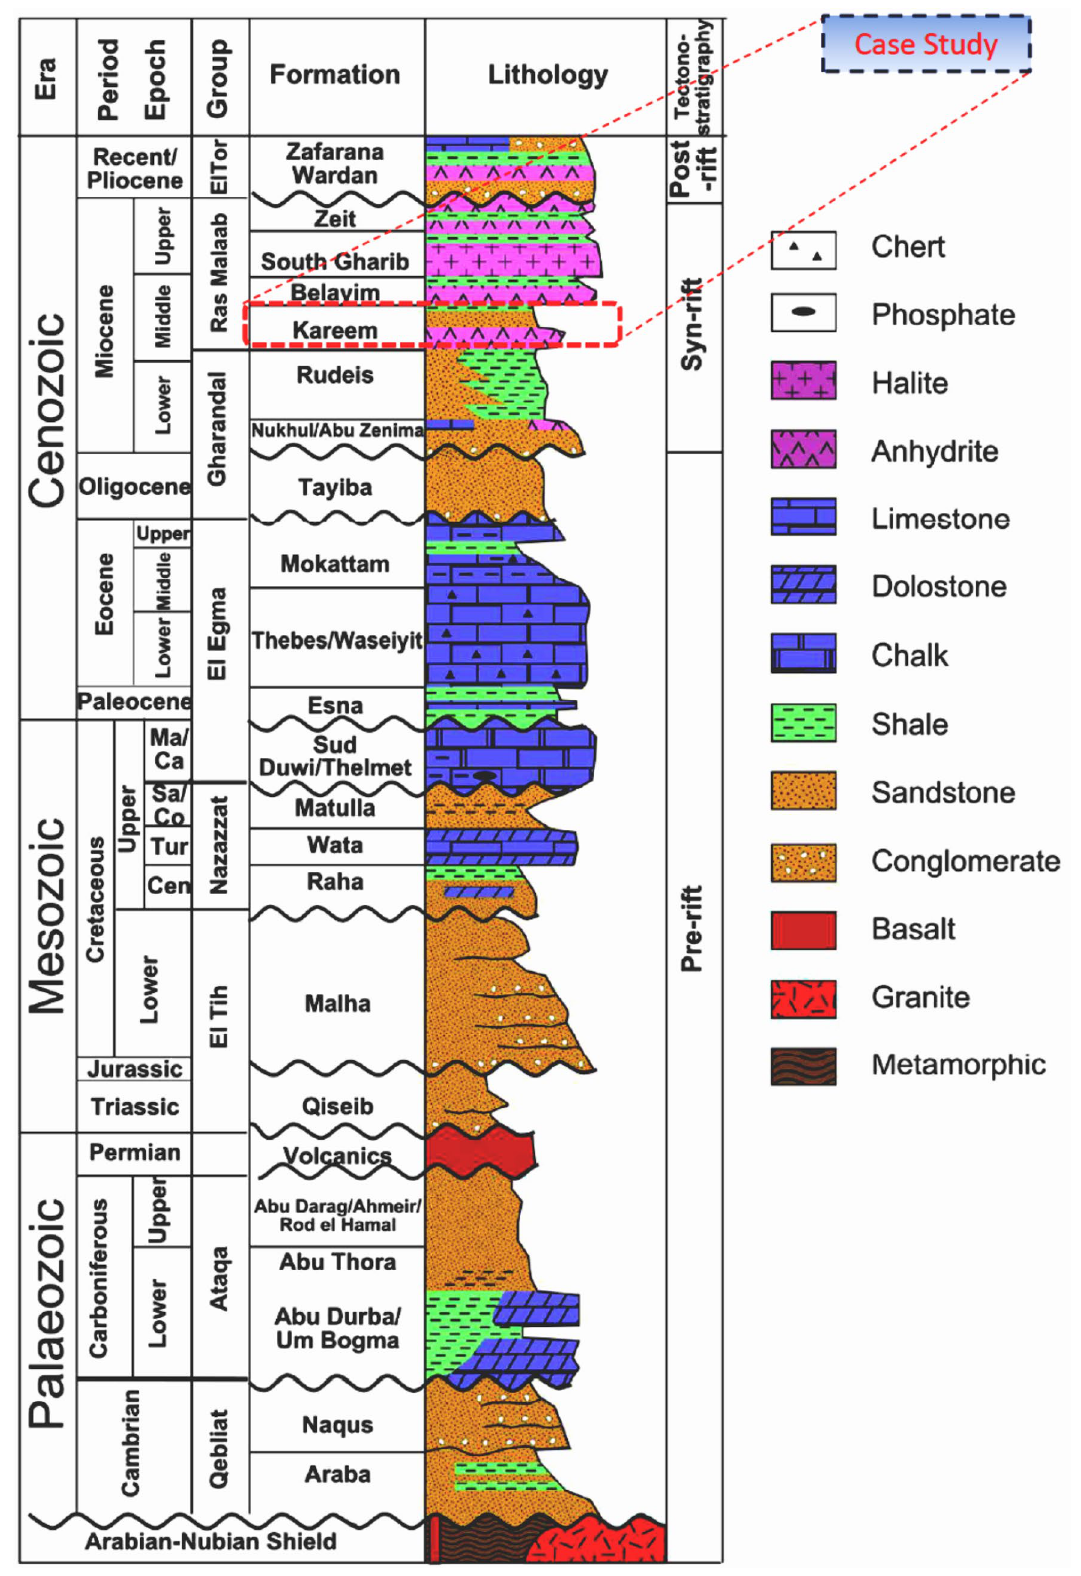
Fig. 2 The generalized stratigraphic column of the Gulf of Suez basin (Darwish and El-Araby